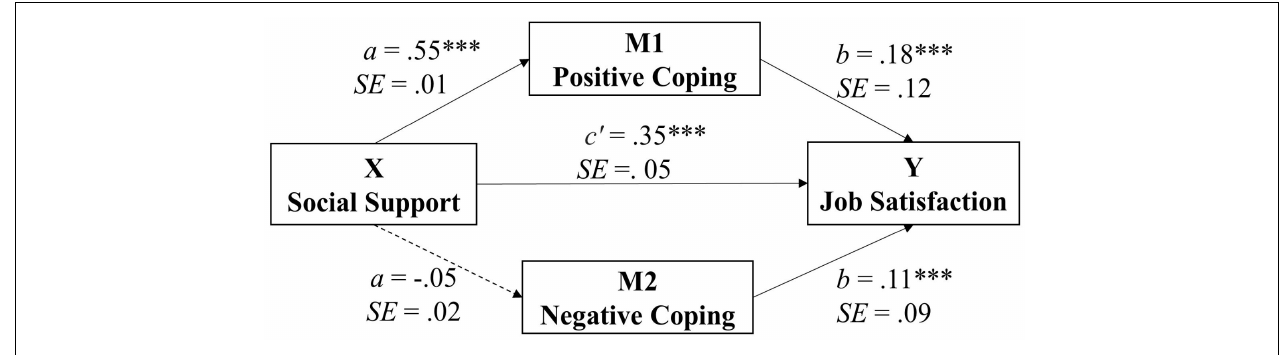
FIGURE 1 | The mediation model for the effect of coping styles on the relationship between social support and job satisfaction. ∗∗∗ p <